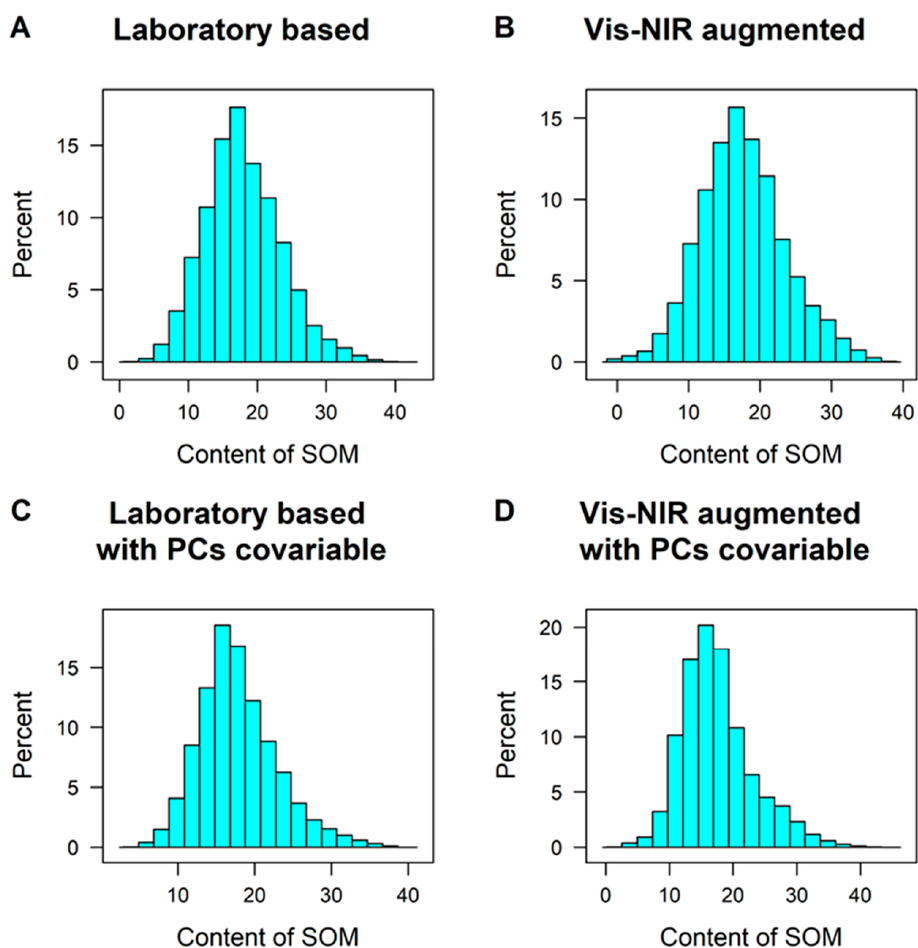
Figure 8. Histogram of predicted SOM using the data of the laboratory-based (Lb), vis-NIR augmented datasets (Au.p), the laboratory-based with pcs covariate (Ld.co), vis-NIR augmented datasets with pcs covariate (Au.p.co).